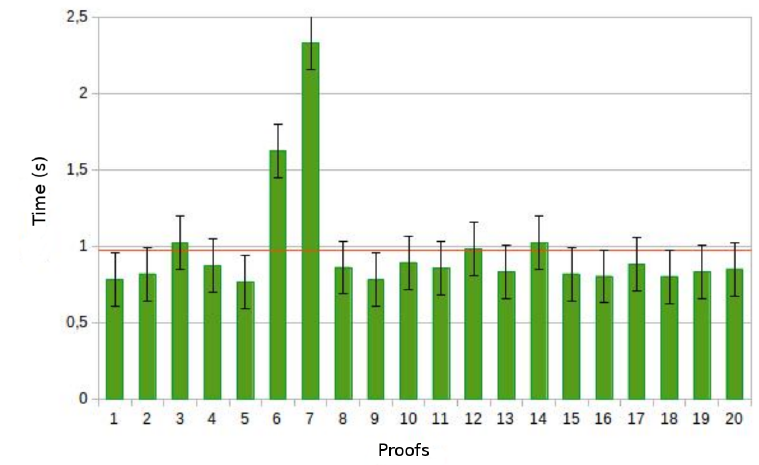
Figure 8. saveAsTextFile action for 500 MB file. 20 proofs average and confidence interval equal to